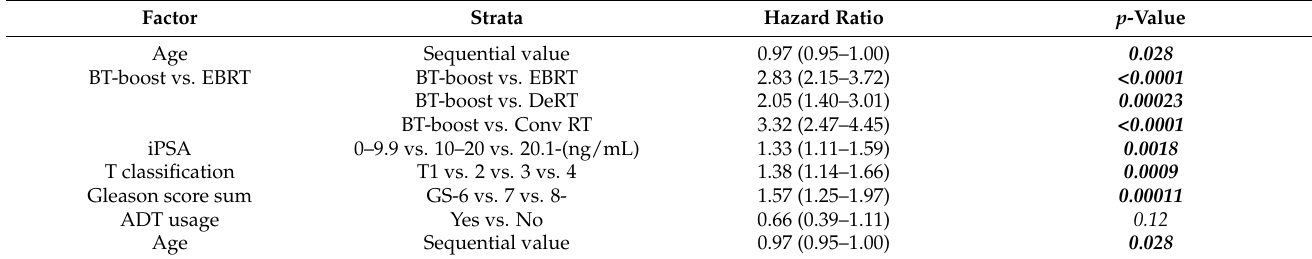
Table 3. Multivariate analysis for PSA control.